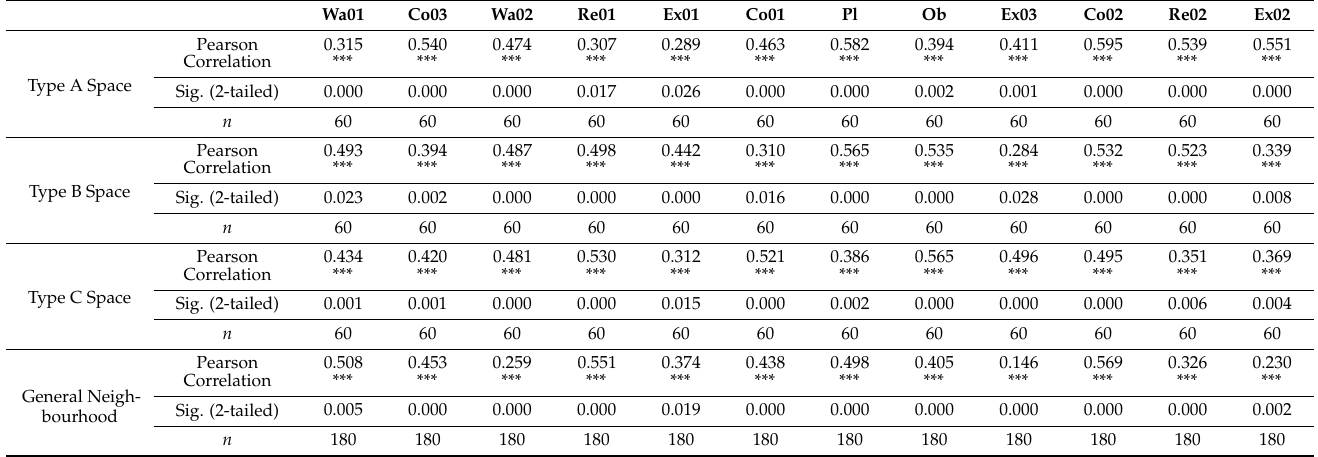
Table 9. Validity test results of the research instrument based on datasets and